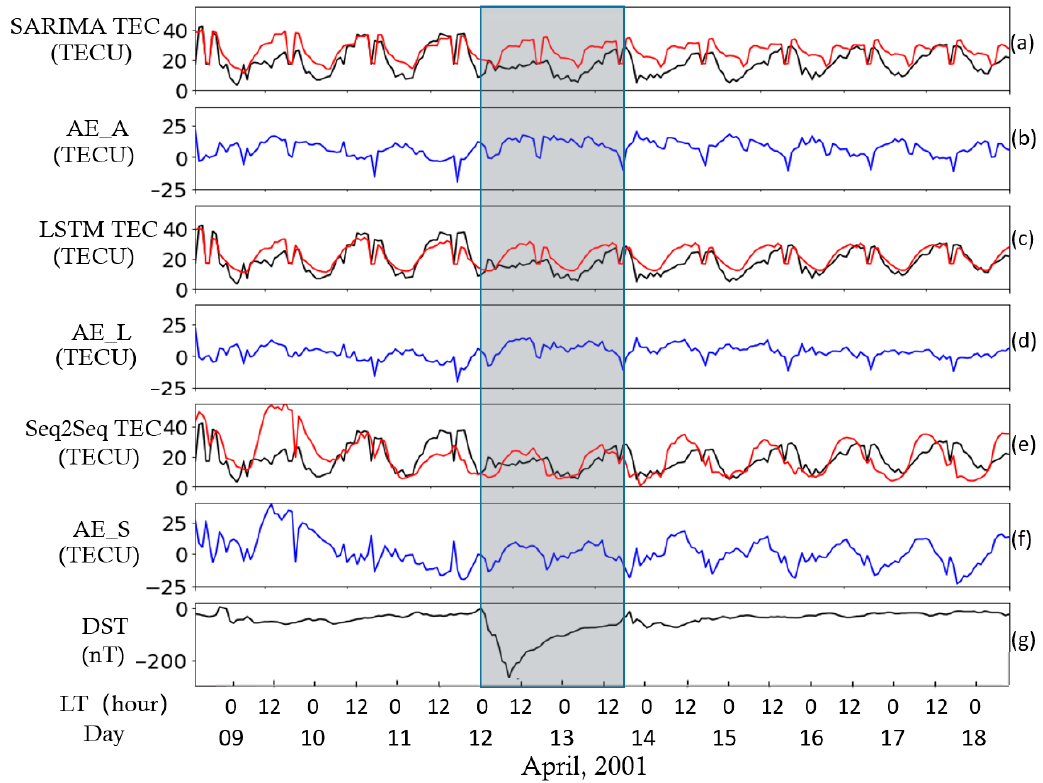
Figure 6. The TEC measurements and predictions under a strong major geomagnetic storm from 8 April to 18 April 2001. All panels have an identical format to Figure 4. Panels ( a ), ( c ), and ( e ) are the measured TEC data (black) and the predicted TEC data (red) by the autoregressive integrated moving average (ARIMA), LSTM, and Seq2Seq methods. Panels ( b ), ( d ), and ( f ) are the absolute errors (blue) between predicted TEC and actual TEC. Panel ( g ) is the geomagnetic disturbance index Dst, and minimum Dst = − 271nT.